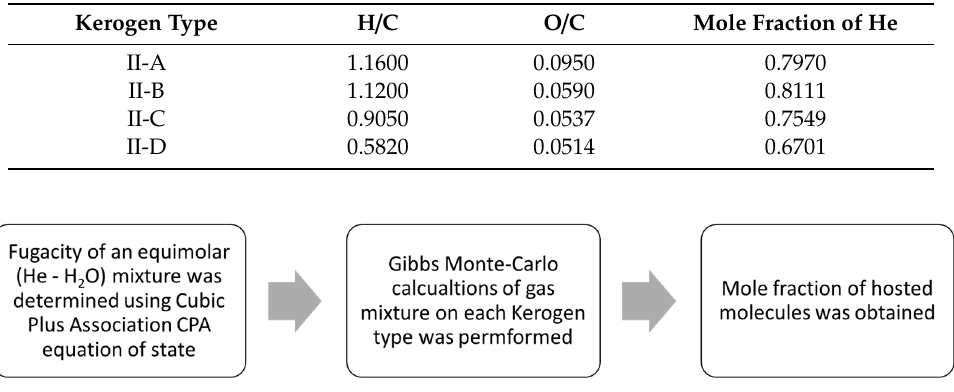
Figure 5. Sample realization of methane molecules adsorbed in II-D kerogen